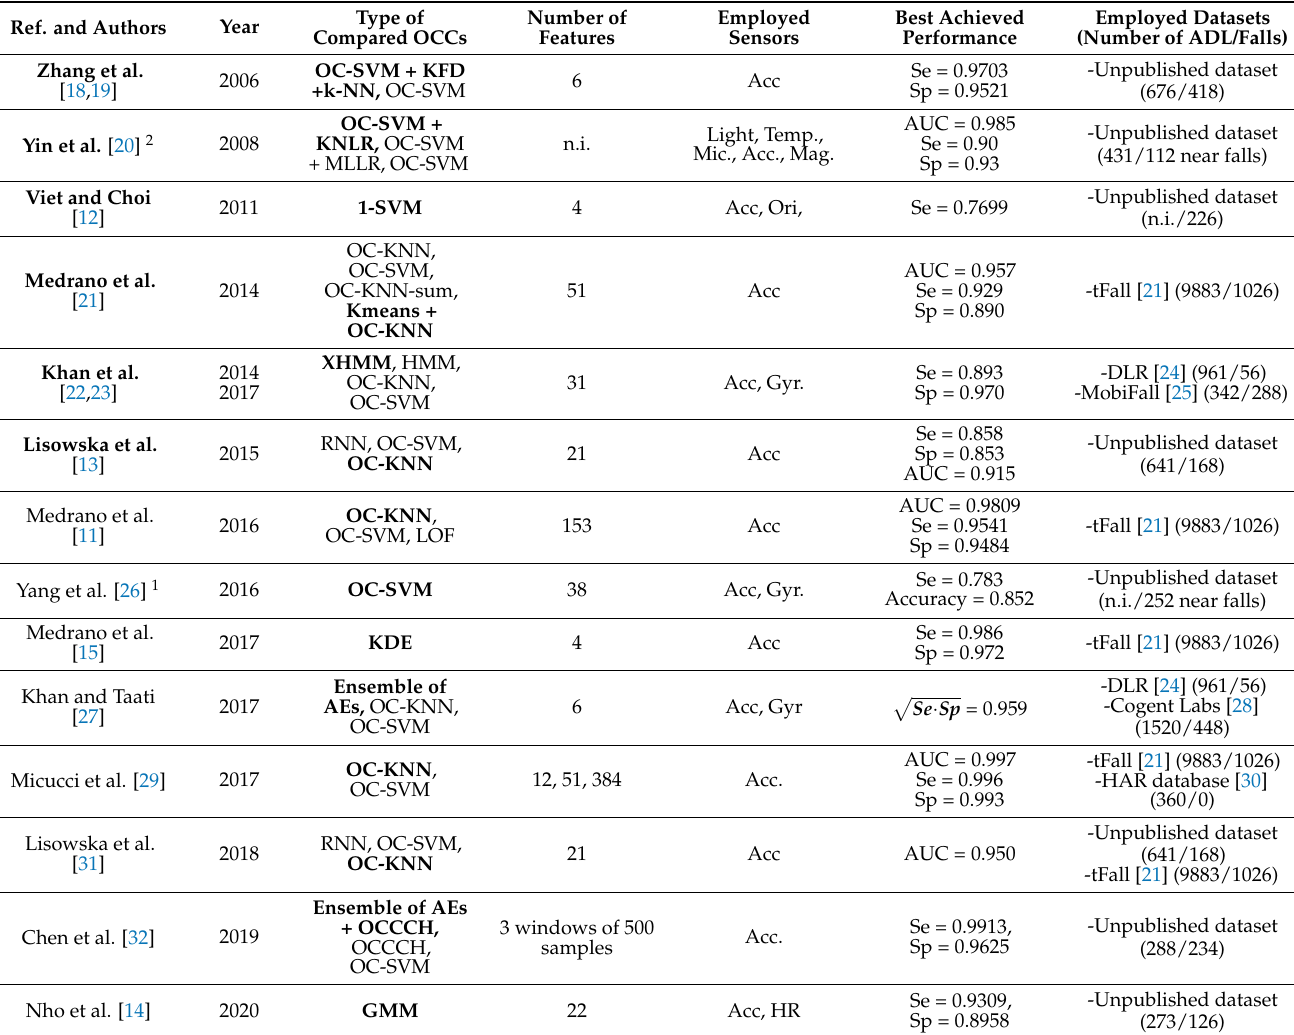
Table 1. Works that have proposed and compared one-class classifiers to detect falls as